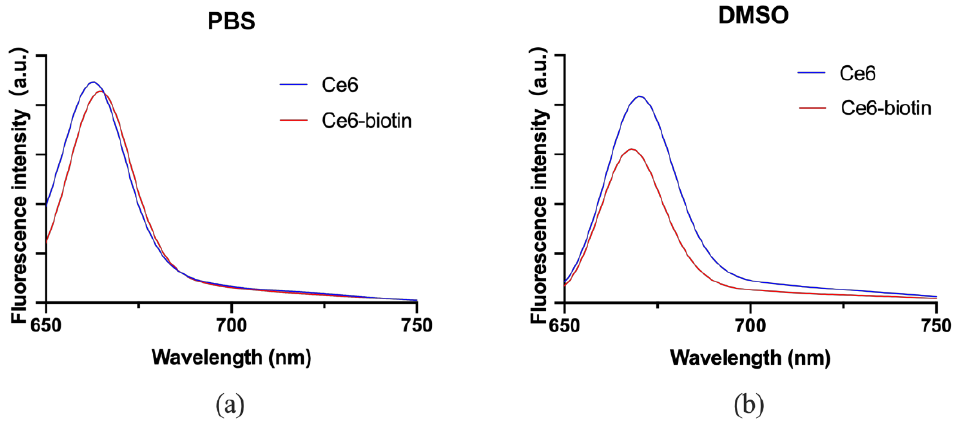
Figure 2. Fluorescence spectra of Ce6 and Ce6-biotin (2 µM) in PBS ( a ) and DMSO ( b ).